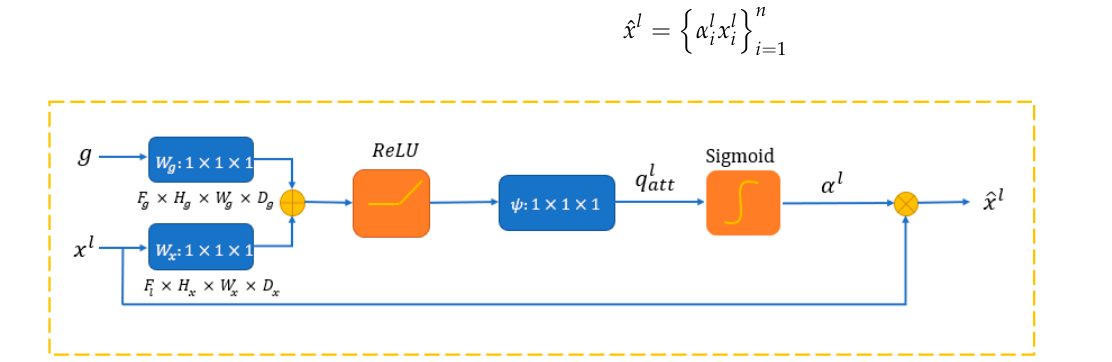
Figure 3. Attention Gates module.